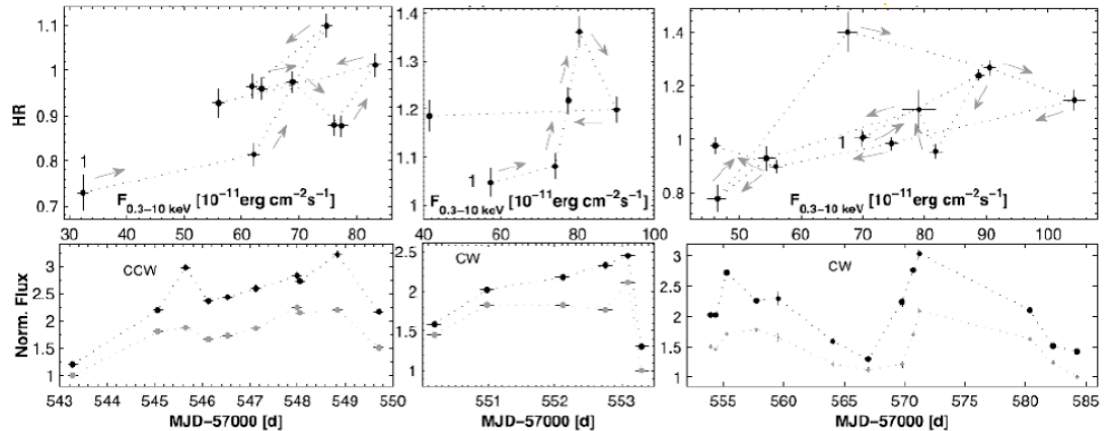
Figure 9. HR-flux planes for the epoch of strong X-ray flaring activity of 1ES 1959+650 in May–November 2017, along with normalized soft 0.3–2 keV(black points) and hard 2–10 keV(gray points) fluxes plotted as a function of time (reproduced from Reference